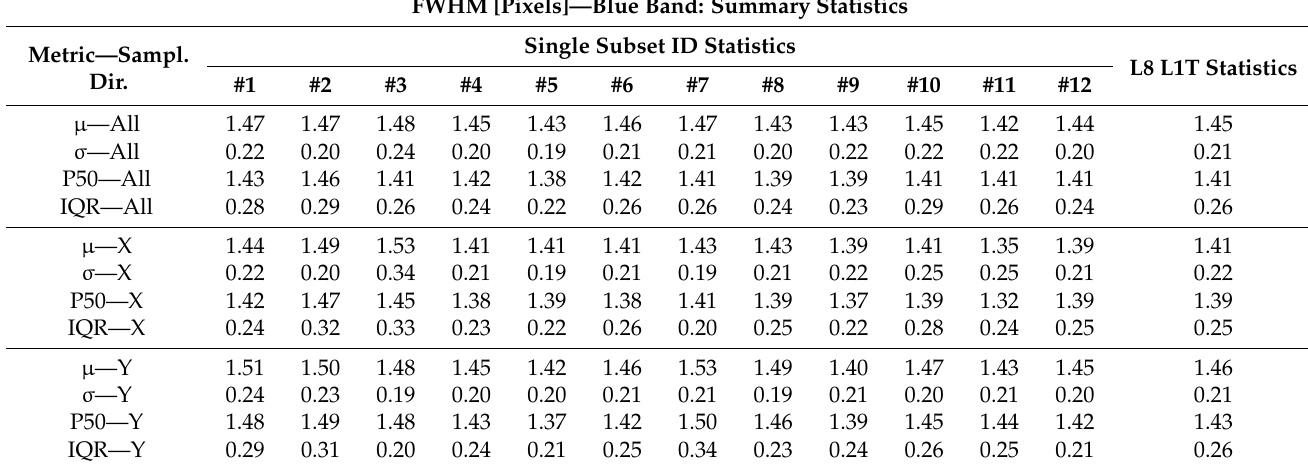
Table 4. SaSbEM validation results for the blue band.